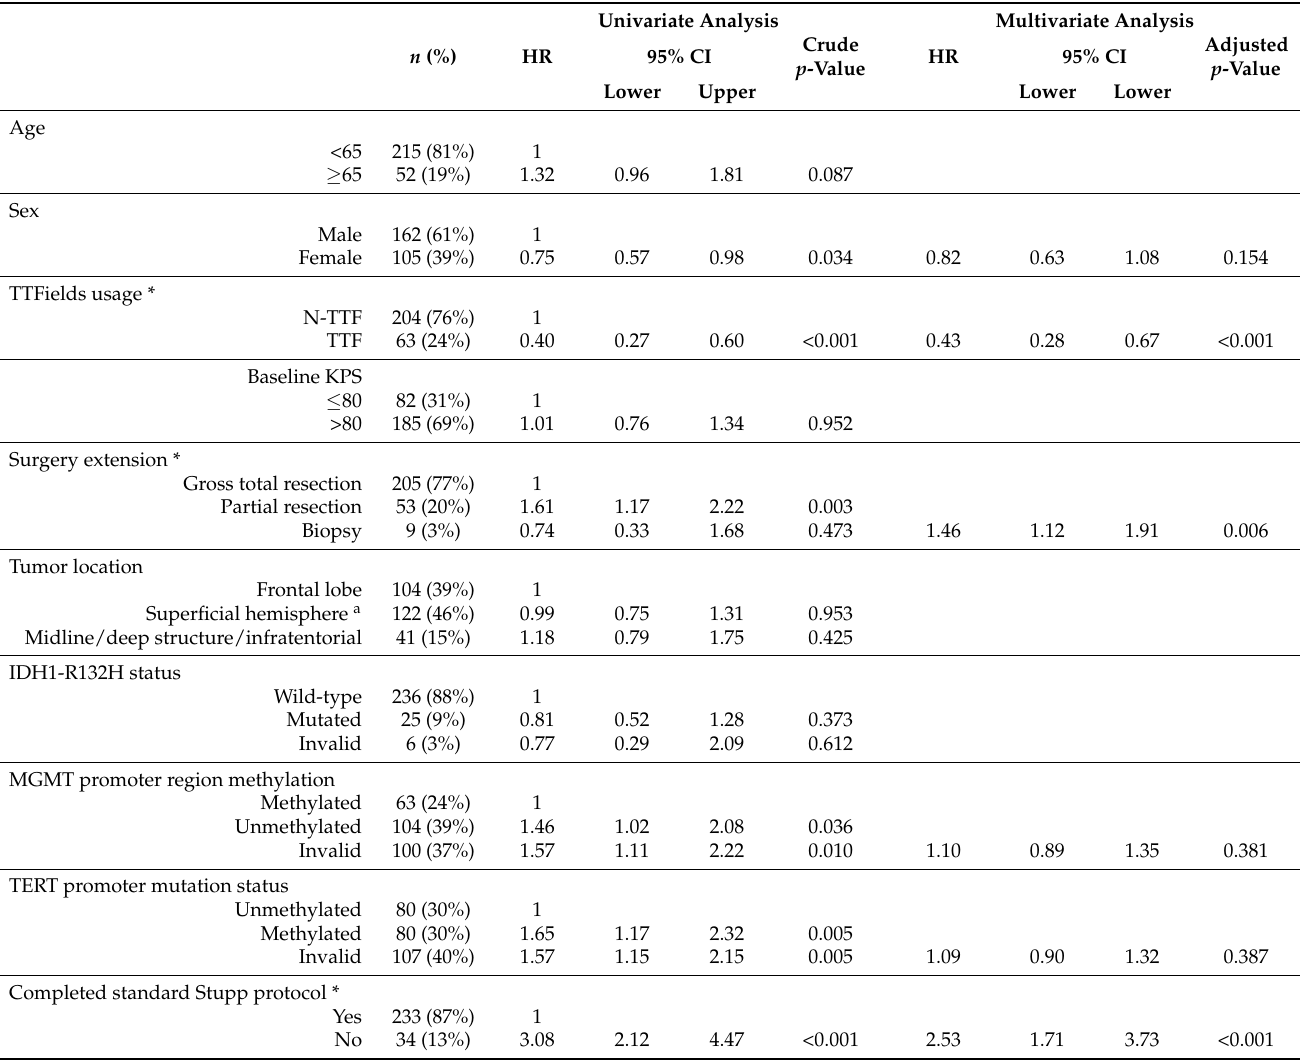
Table 3. Univariate and multivariate analyses of overall survival (OS) in GBM